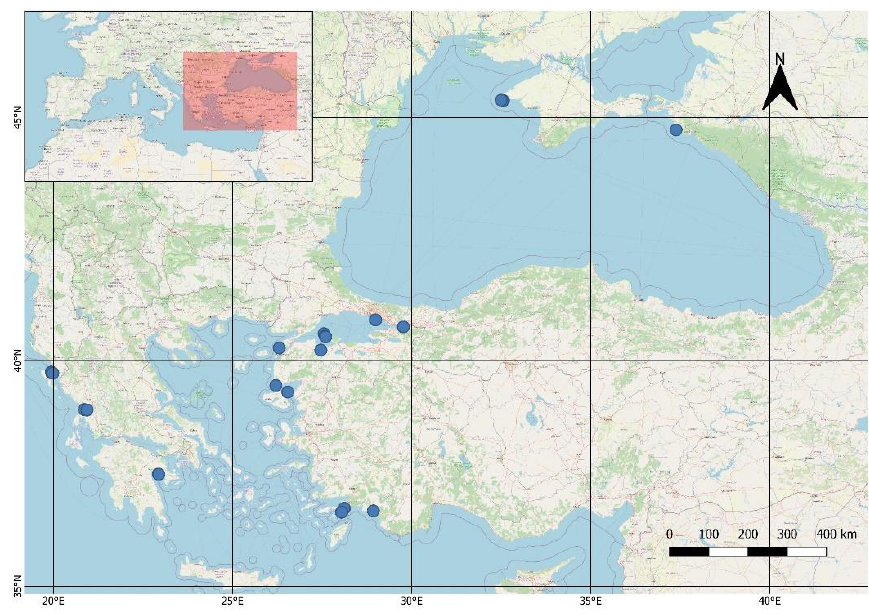
Figure 5. Records of Gobius bucchichi in the Aegean Sea, Sea of Marmara and Black Sea .